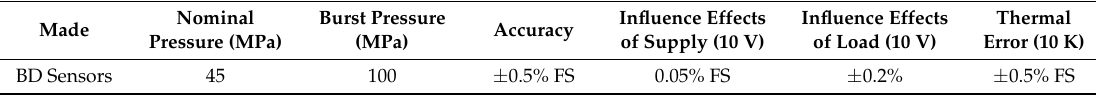
Table 1. Main parameters of the pressure transducer of DMK 331P.